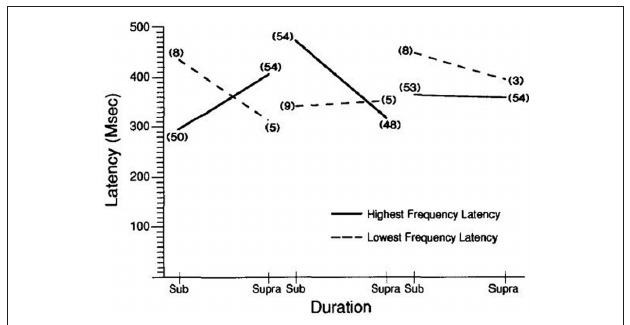
Figure 1 | relationship between latency and duration for highest and lowest frequencies by word category. (Left) Unconscious conflict words (U); (middle) conscious symptom words (C); (right) Osgood unpleasant words (E–). Numbers in parentheses are the frequency